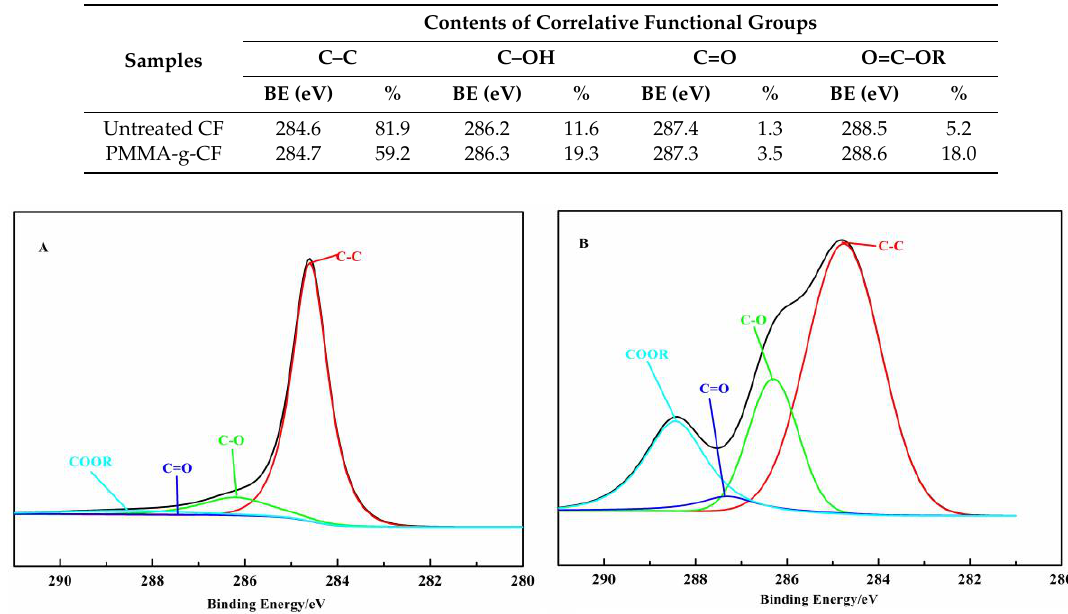
Figure 4. XPS C1s spectra of ( A ) untreated CF and ( B ) PMMA-g-CF.